Question: Give a one-sentence summary of this figure.
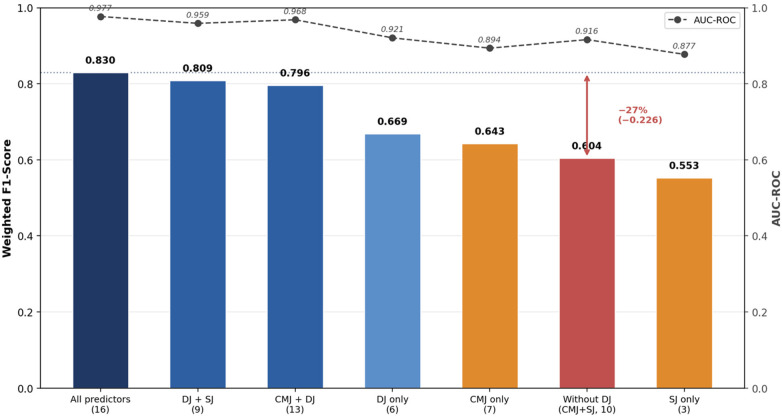
Answer: Variable subset ablation by jump test using logistic regression. The full model (16 predictors) achieved an F1 score of 0.830. Removing all drop-jump variables (“Without DJ”) reduced F1 to 0.604, a 27% relative reduction, confirming the central discriminative role of the drop jump.